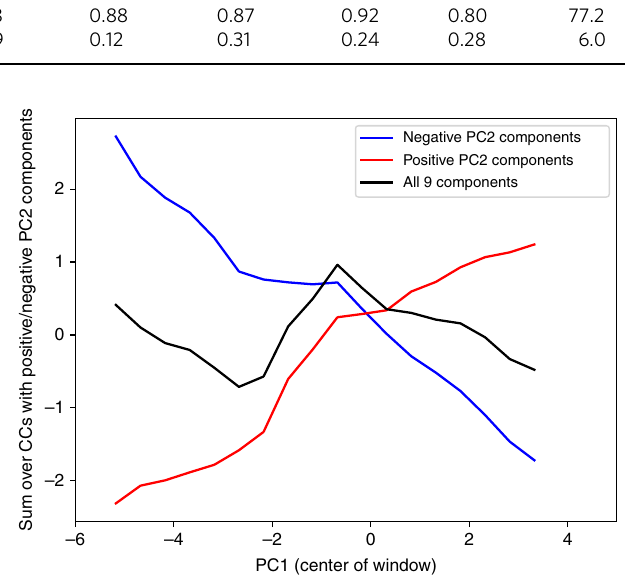
Fig. 3 The decomposition of the average PC2 into two subsets of CCs. The red line represents the CC components related to information- processing capabilities ( writing , money , texts , infrastructure , and gvrnmt in order of importance), having positive correlations with PC2. The blue line represents the CC components primarily related to scale ( PolPop , levels , CapPop , and PolTerr in order of importance). Note the changes in gradients along these two lines as they traverse PC1. The black line here is identical to the blue line in Fig. 2, with a change of